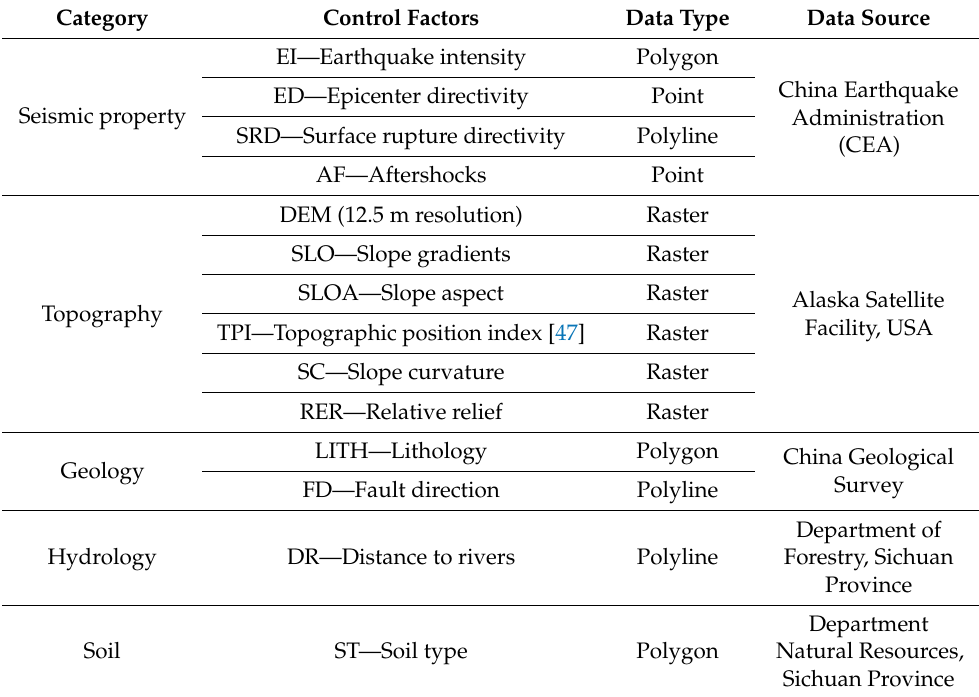
Table 3. List of data sources used as controlling factors in this